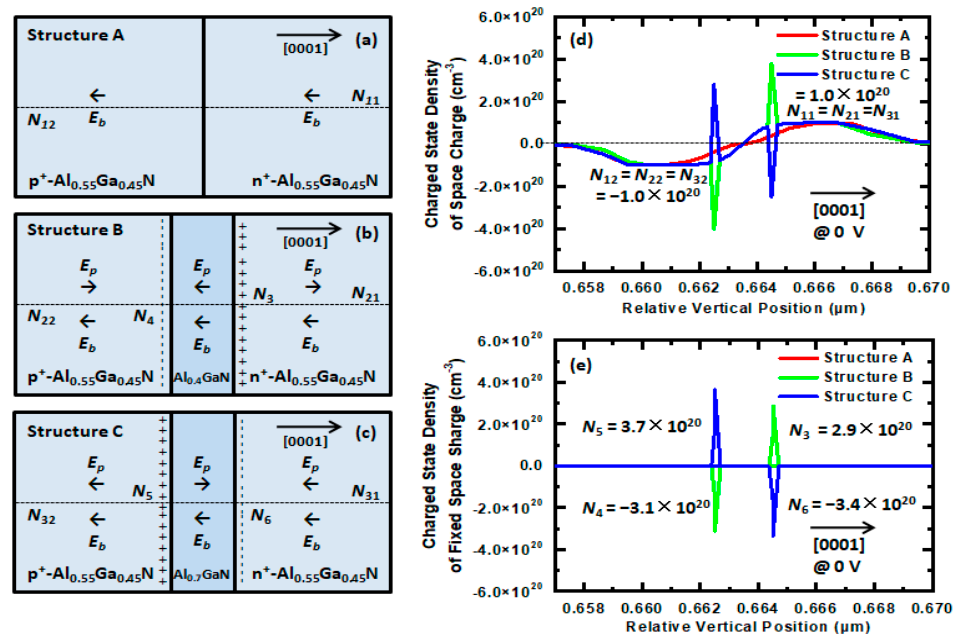
Figure 2. Distributions of the electric fields ( a – c ), the charged state densities of the space charges ( d ) and the charged state densities of the fixed space charges at the interfaces ( e ) in TJs in Structures A, B, and C at a bias voltage of 0 V. N is the charged state density of the space charge. For Structure A, the TJ is a p + –n + homojunction and E c comes from the contribu- tion of only E b , as shown in Figure 2a. E b comes from the ionized dopant in the space charge region; has a direction along the [000-1] orientation, beginning with N 11 in the n + -Al 0.55 Ga 0.45 N layer and ending with N 12 in the p + -Al 0.55 Ga 0.45 N layer; and can be calculated as N 11 = 1.0 × 10 20 cm − 3 and N 12 = − 1.0 × 10 20 cm − 3 , as shown in Figure 2d. For Structure B, the PTJ is a p + –i–n + heterojunction, and E c comes from the contributions of E b and E p , as shown in Figure 2b. E b has a direction along the [000-1] orientation, beginning with N 21 in the n + -Al 0.55 Ga 0.45 N layer and ending with N 22 in the p + -Al 0.55 Ga 0.45 N layer, and it can be calculated as N 21 = 1.0 × 10 20 cm − 3 and N 22 = − 1.0 × 10 20 cm − 3 , as shown in Figure 2d. E p is built up from the differences between N 3 at the Al 0.4 Ga 0.6 N/n + -Al 0.55 Ga 0.45 N interface and N 4 at the p + -Al 0.55 Ga 0.45 N/Al 0.4 Ga 0.6 N interface, where N 3 > 0 and N 4 < 0 under compressive strain of Al 0.4 Ga 0.6 N, and can be calculated as N 3 = 2.9 × 10 20 cm − 3 and N 4 = − 3.1 × 10 20 cm − 3 , as shown in Figure 2e. E p has a direction along the [000-1] orientation in the Al 0.4 Ga 0.6 N layer, in the same direction as E b , and a direction along the [0001] orientation at both sides of the Al 0.4 Ga 0.6 N layer, in the reverse direction to E b , as shown in Figure 2b. For Structure C, the PTJ is also a p + –i–n + heterojunction, and E c also comes from the con- tributions of E b and E p , as shown in Figure 2c. E b has a direction along the [000-1] orientation, beginning with N 31 in the n + -Al 0.55 Ga 0.45 N layer and ending with N 32 in the p + -Al 0.55 Ga 0.45 N layer, and can be calculated as N 31 = 1.0 × 10 20 cm − 3 and N 32 = − 1.0 × 10 20 cm − 3 as shown in Figure 2d. E p is built up from the differences between N 5 at the p + -Al 0.55 Ga 0.45 N/Al 0.7 Ga 0.3 N interface and N 6 at the Al 0.7 Ga 0.3 N/n + -Al 0.55 Ga 0.45 N interface, where N 5 > 0 and N 6 < 0 under tensile strain of Al 0.7 Ga 0.3 N, and can be calculated as N 5 = 3.7 × 10 20 cm − 3 and N 6 = − 3.4 × 10 20 cm − 3 , as shown in Figure 2e. E p has a direction along the [0001] orienta- tion in the Al 0.7 Ga 0.3 N layer, in the reverse direction to E b , and a direction along the [000-1] orientation at both sides of the Al 0.7 Ga 0.3 N layer, in the same direction as E b , as shown in Figure